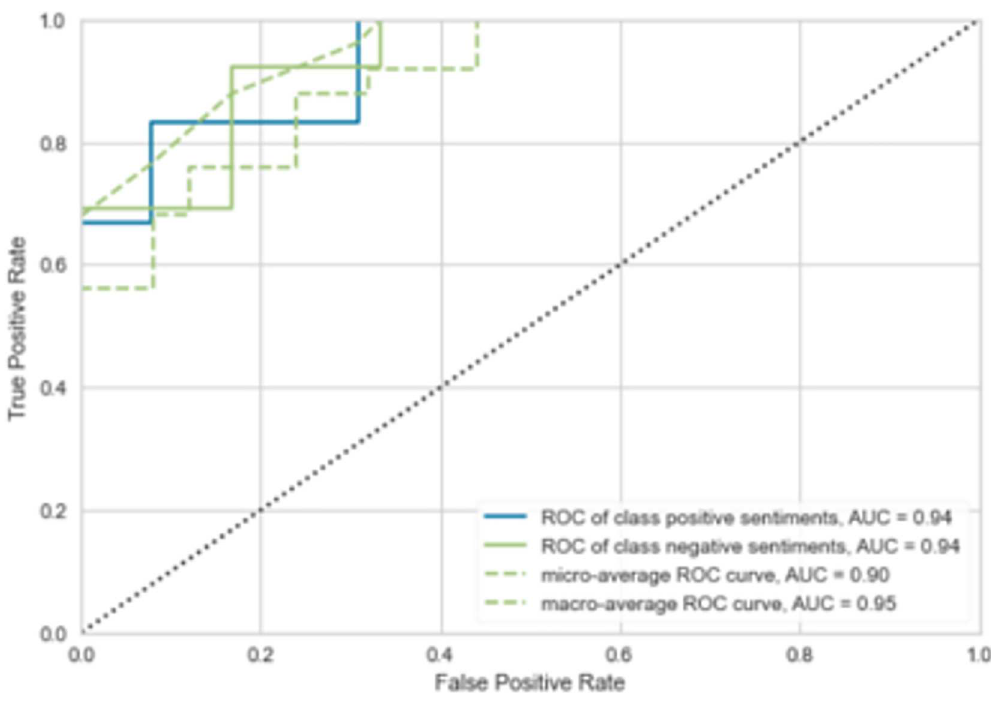
Fig 35. ROC curves for the proposed DNN model.